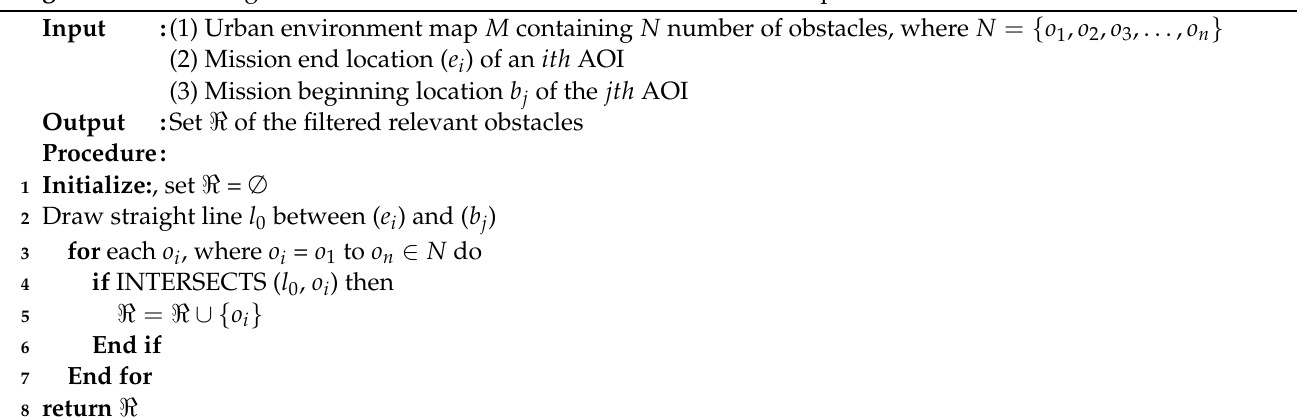
Algorithm 3: Filtering relevant obstacles from the urban environment